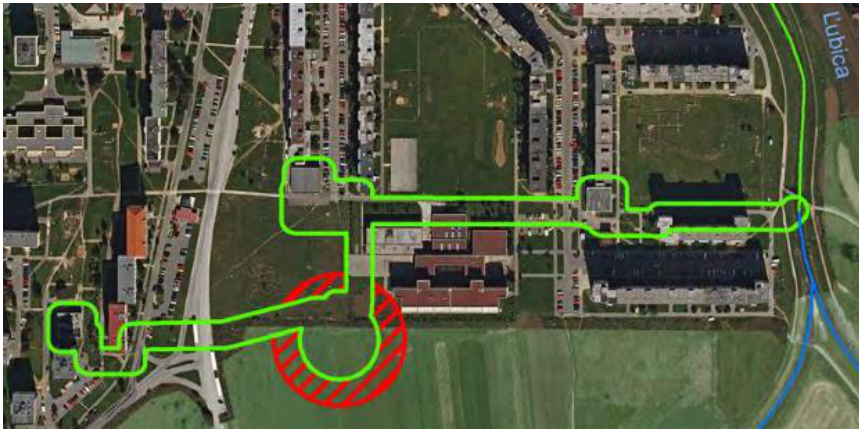
Figure 5. Location of the proposed GTK-1 well area under investigation [21].